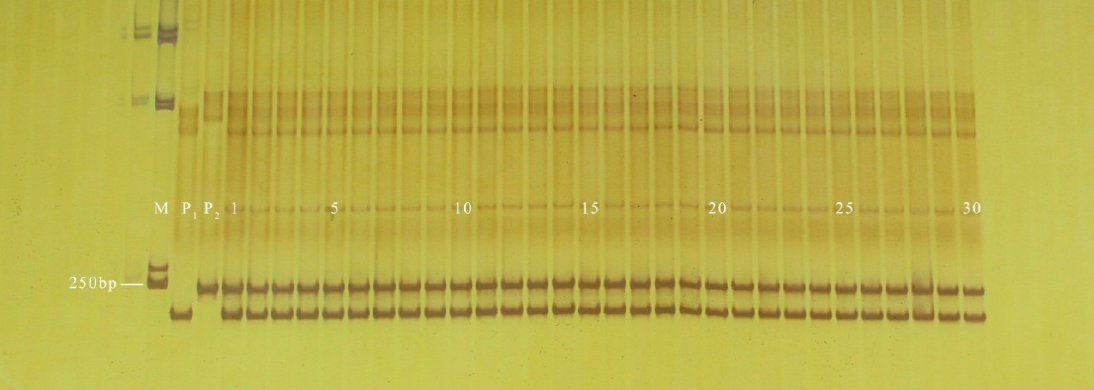
Figure 10. Purity identification of some plants of ‘Fenxianzi 11 ′ wax gourd by GX2. M: DL2000 DNA Marker; P 1 : ymy-24-1-6-1 (nearly spherical); P 2 : GF-7-1-1 (cylindrical); 1–30: ‘Fenxianzi 11 ′ wax gourd.